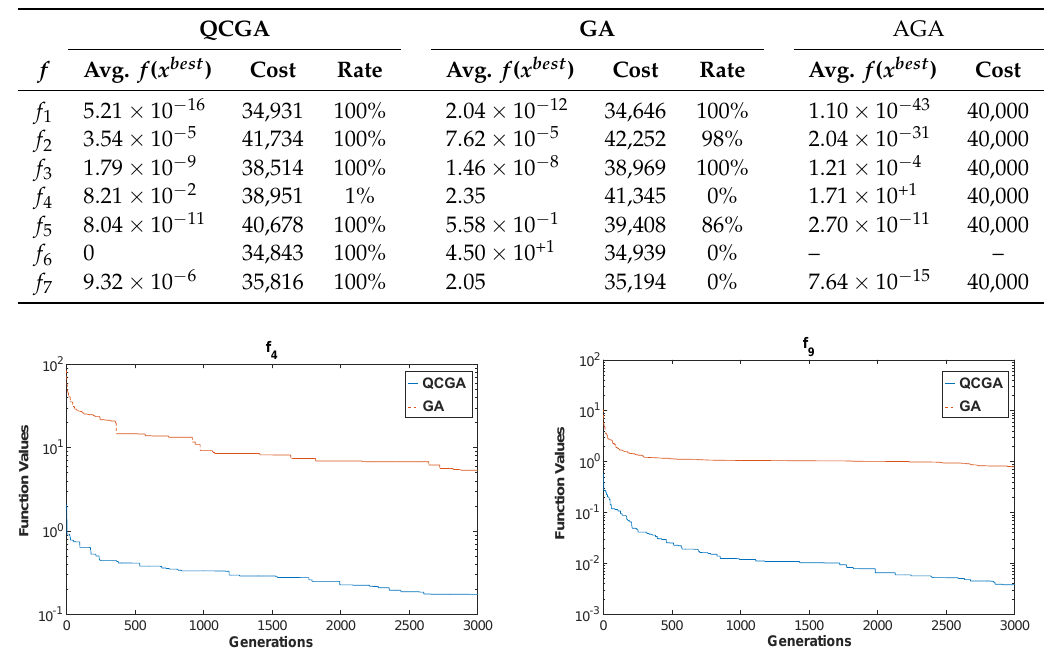
Table 3. Solutions qualities and costs of the proposed and compared methods.